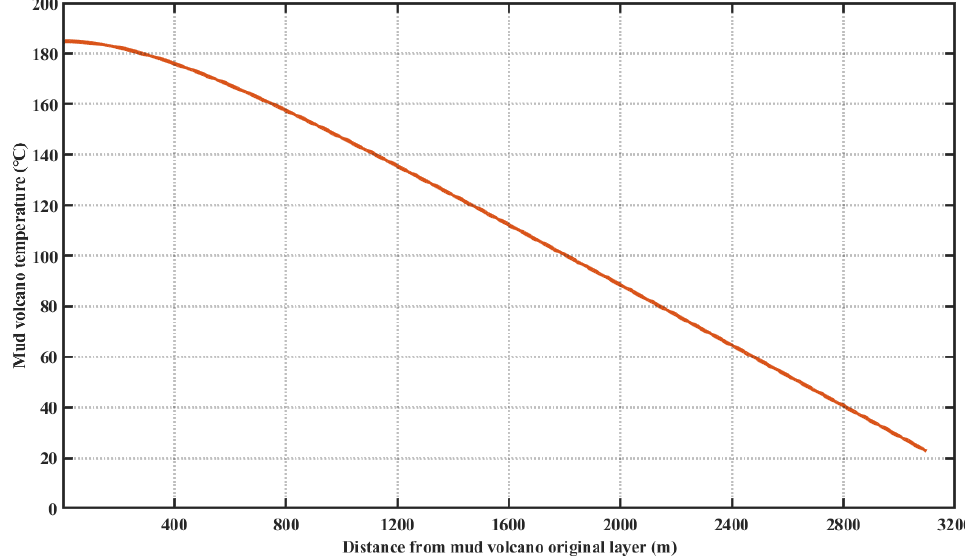
Figure 4. Temperature variation curve of the thermal fluid at different depth in the mud volcanic channel, where distance (z) = 0 is where the fluid flow originates. Here, the initial temperature of the mud volcano is 185 °C and the channel width is 1000 m. Other parameters are listed in Table 2.